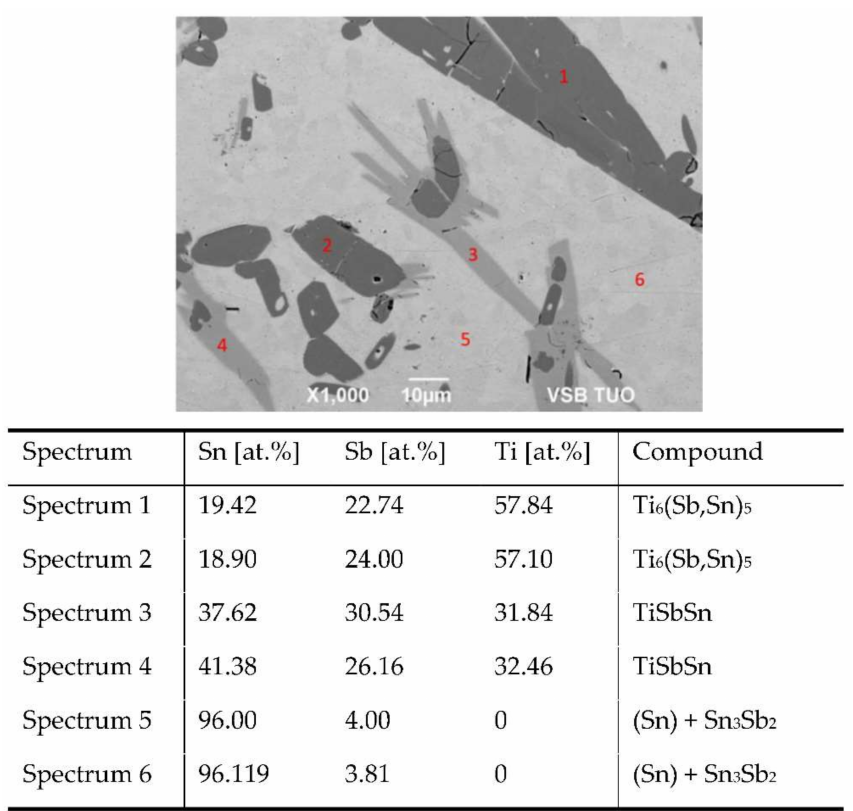
Figure 5. Point EDX analysis of Sn5Sb3Ti